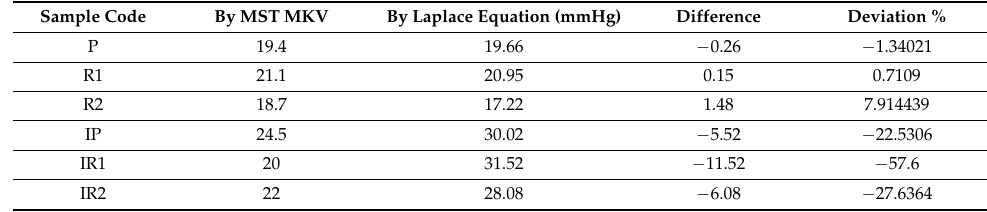
Table 7. Comparison of results using both